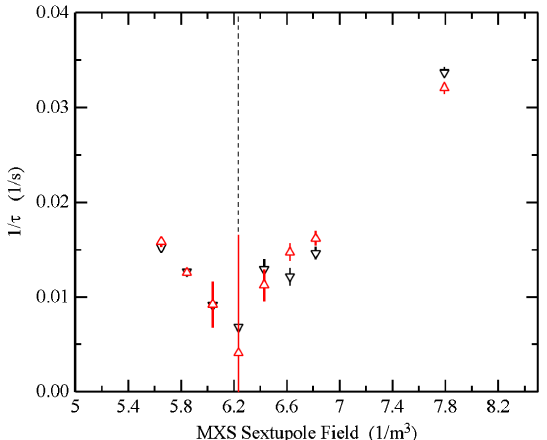
FIG. 18. Same as Fig. 15 but for wide beam scan 4, shown as a function of G ( S ¼ 3 . 90 m − 3 ).